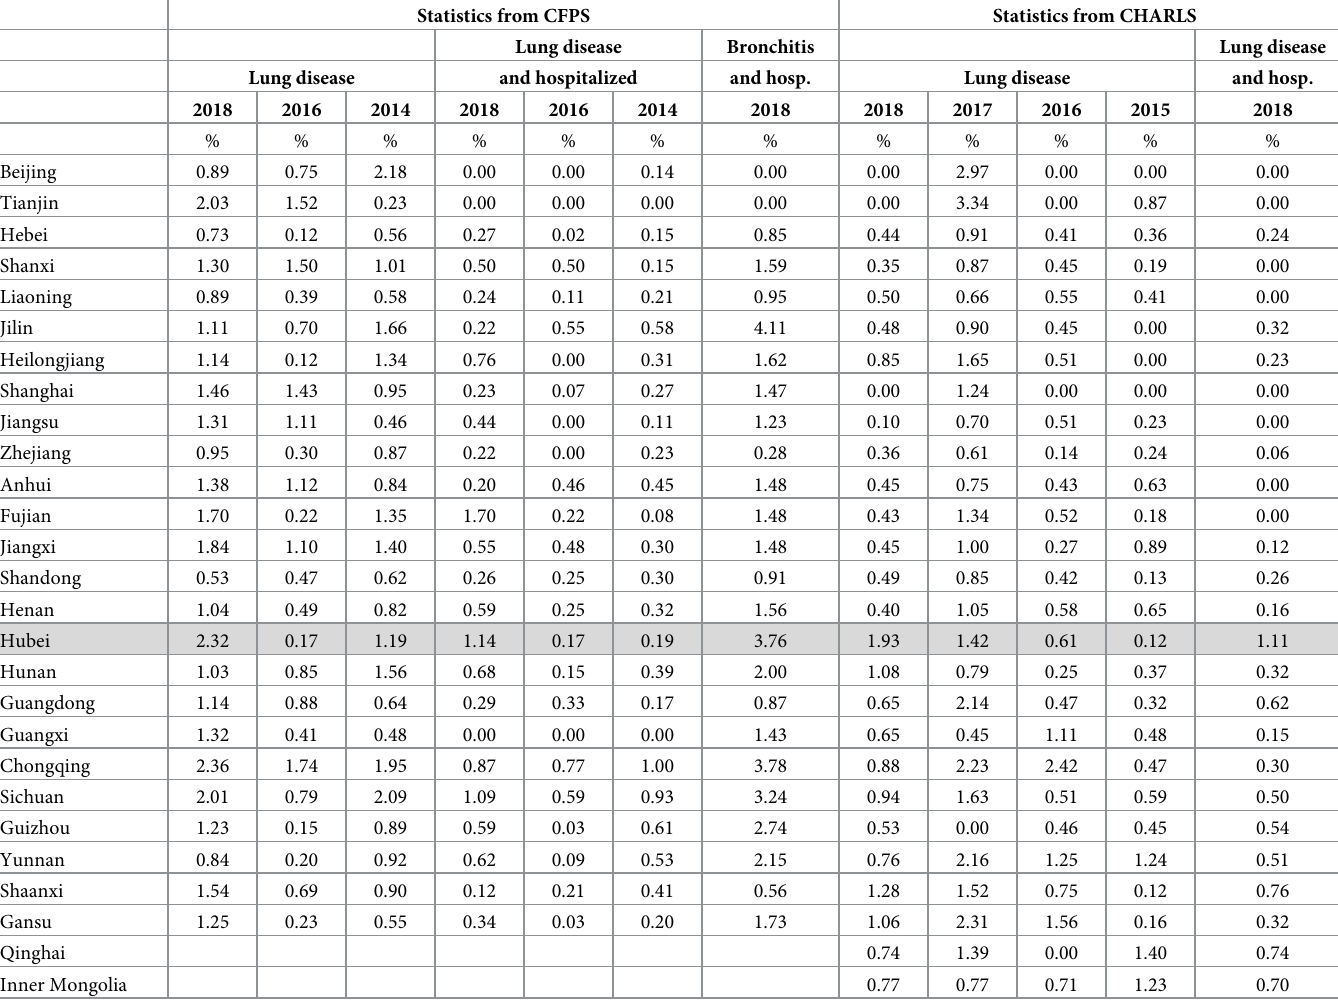
Table 5. Diagnosis of lung disease by province and